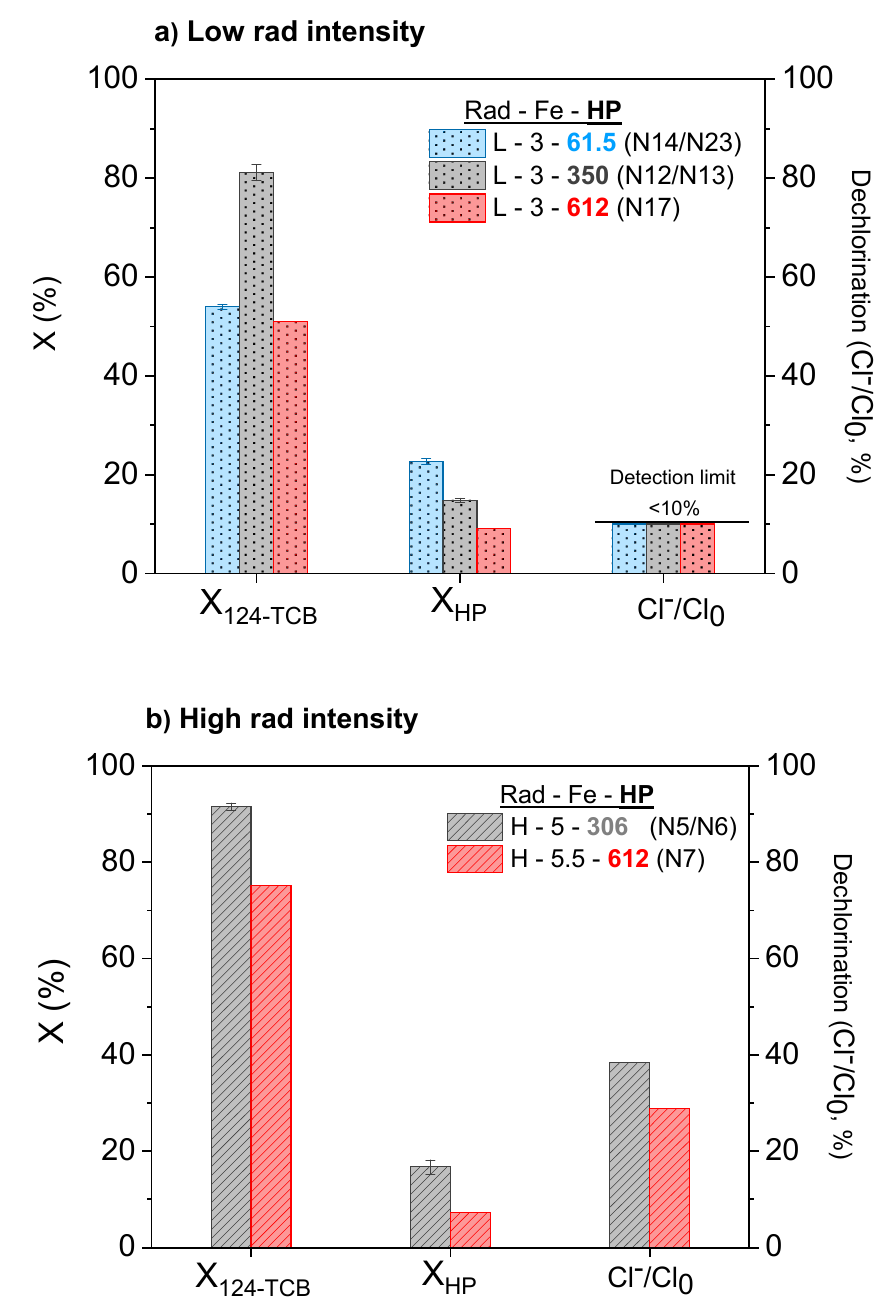
Figure 3. Effect of the oxidant concentration on 124-TCB and HP conversions and dechlorination degree achieved after 180 min of reaction. Experimental conditions: 124-TCB = 28 mg L − 1 , ( a ) Low Figure 3. E ff ect of the oxidant concentration on 124 − TCB and HP conversions and dechlorination rad intensity, and ( b ) High rad degree achieved after 180 min of reaction. Experimental conditions: 124–TCB = 28 mg L − 1 , ( a ) Low rad intensity, and ( b ) High rad intensity.